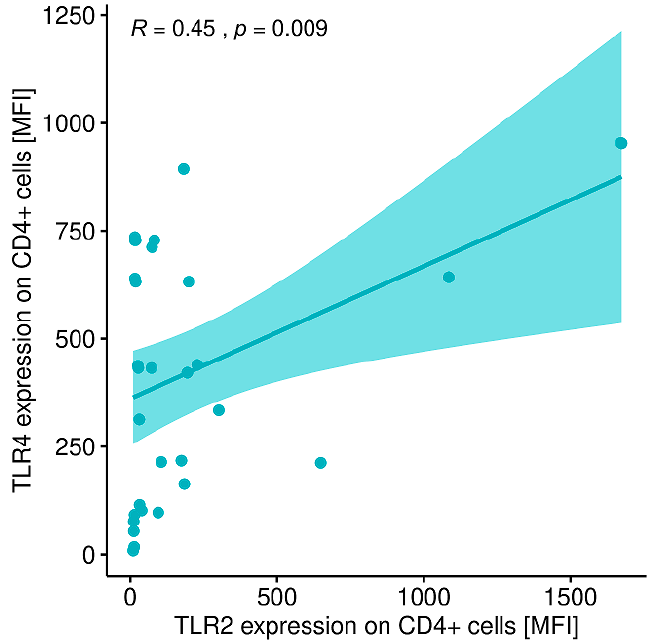
Figure 9. Correlation between the expression level of TLR-2 on CD4+ T lymphocytes (MFI) and the expression level (MFI) of TLR-4 on CD4+ T lymphocytes (MFI) in patients with GD before treatment. MFI, mean fluorescence intensity.